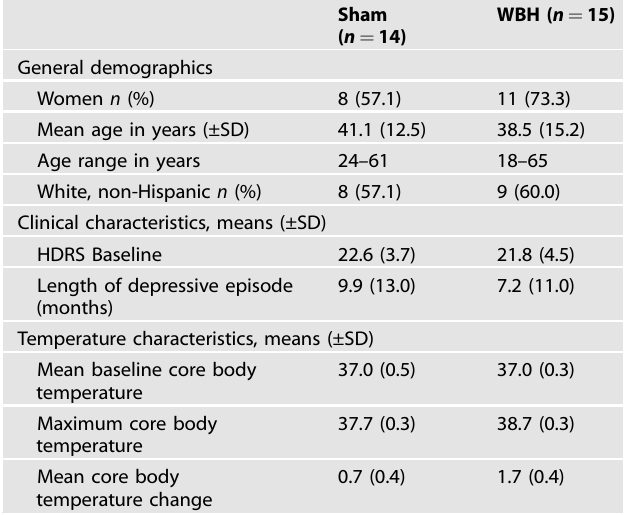
Table 1. Demographics, baseline clinical characteristics, and baseline and WBH-induced changes in core body